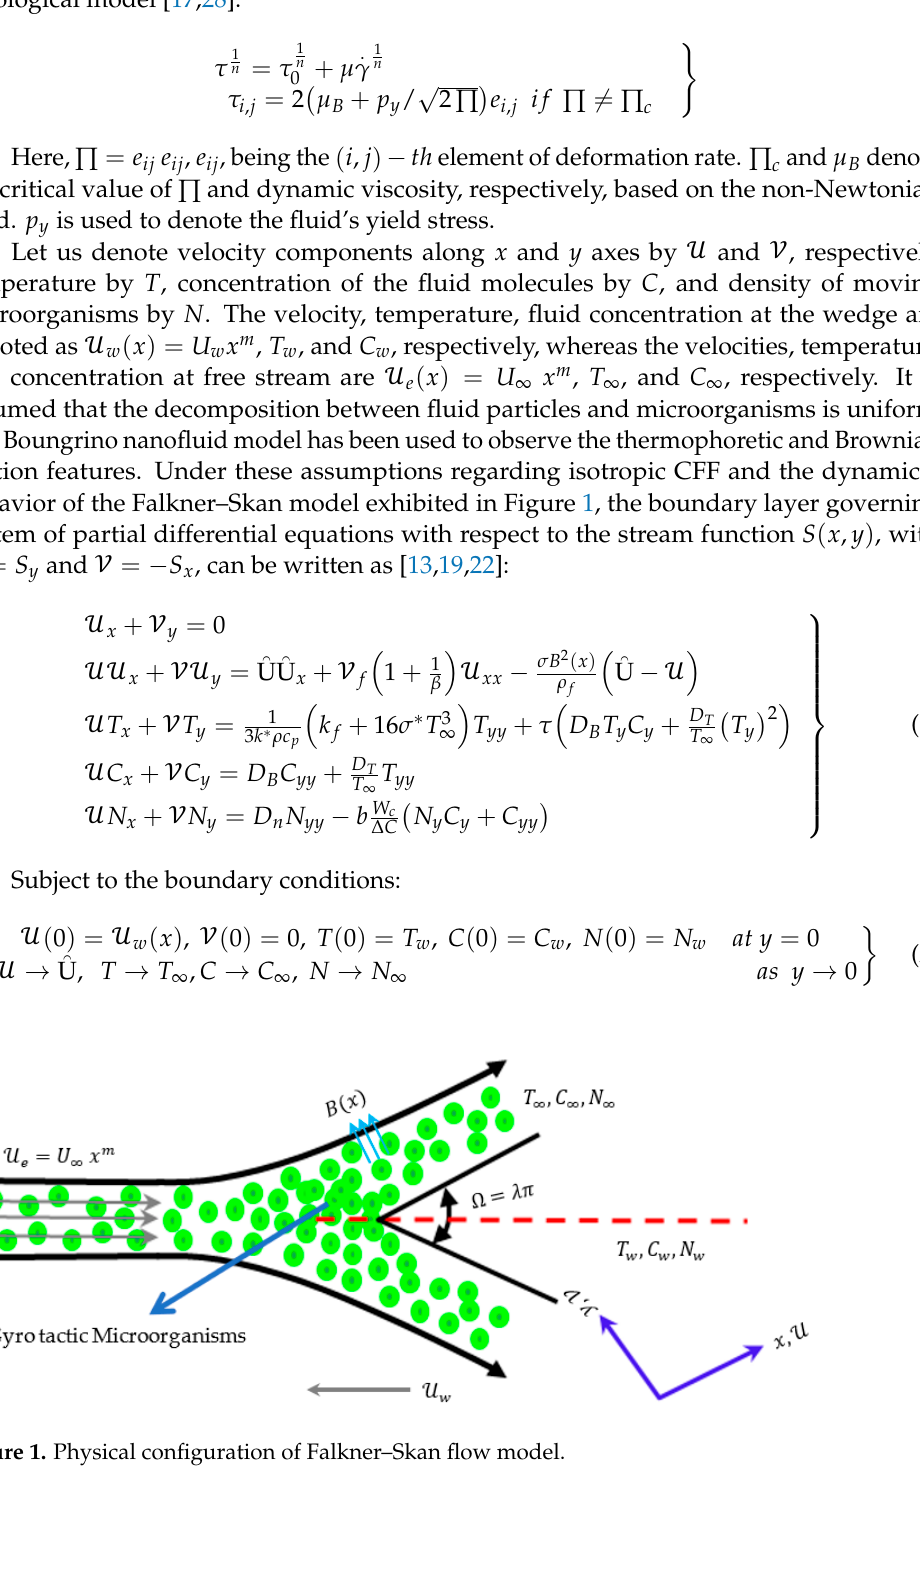
Figure 1. Physical con fi guration of Falkner–Skan fl ow model.